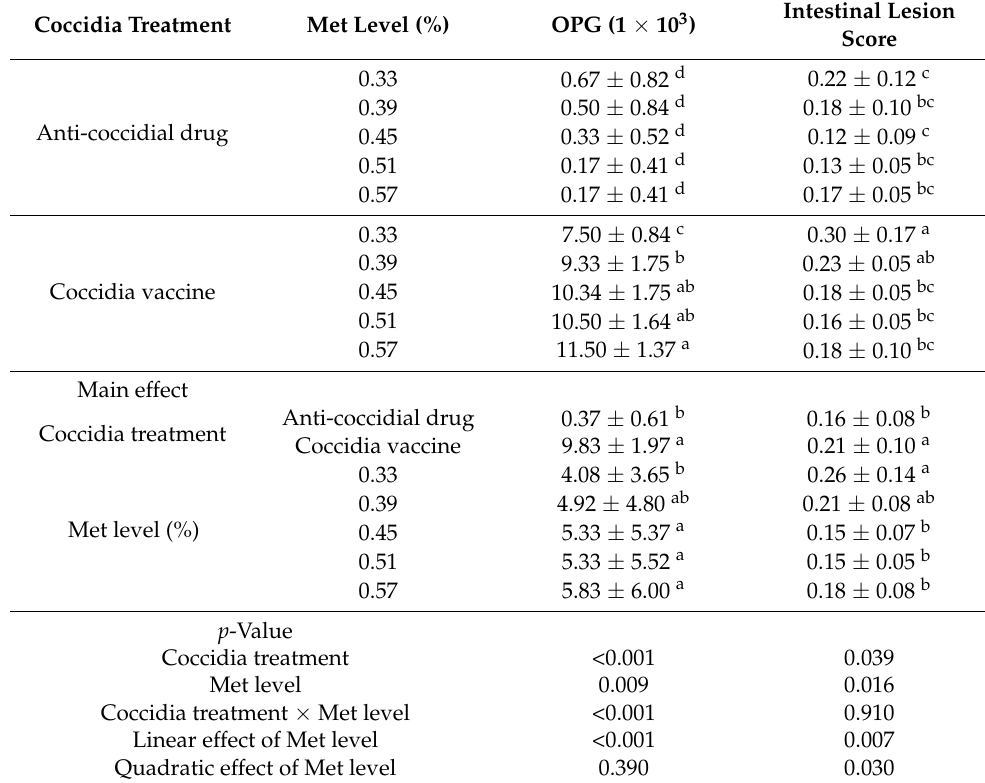
Table 4. Effect of different treatments on the OPG and intestinal lesion score of 1~21 d partridge shank